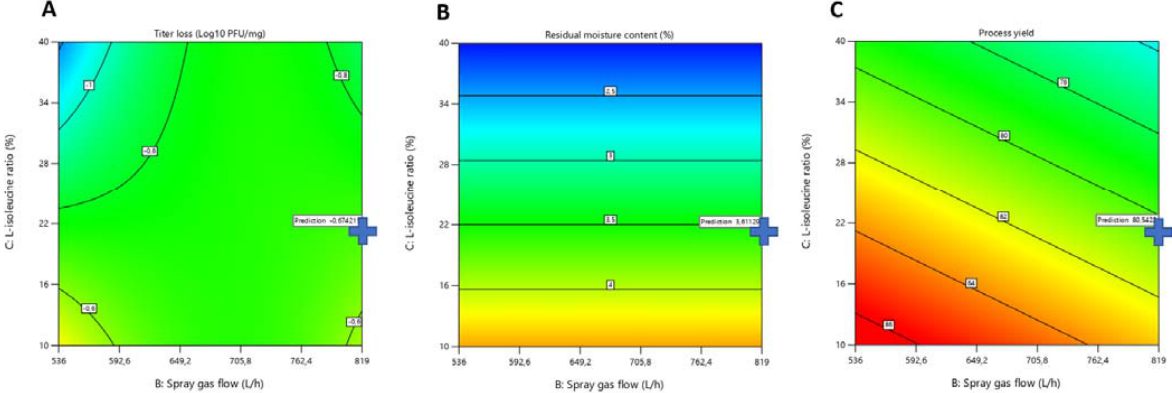
Figure 6. 14-1 contour plot: Representation of Titer loss ( A ); Residual Moisture Content ( B ); and Process yield ( C ) against combinations of Spray gas flow and L-isoleucine ratio factors.